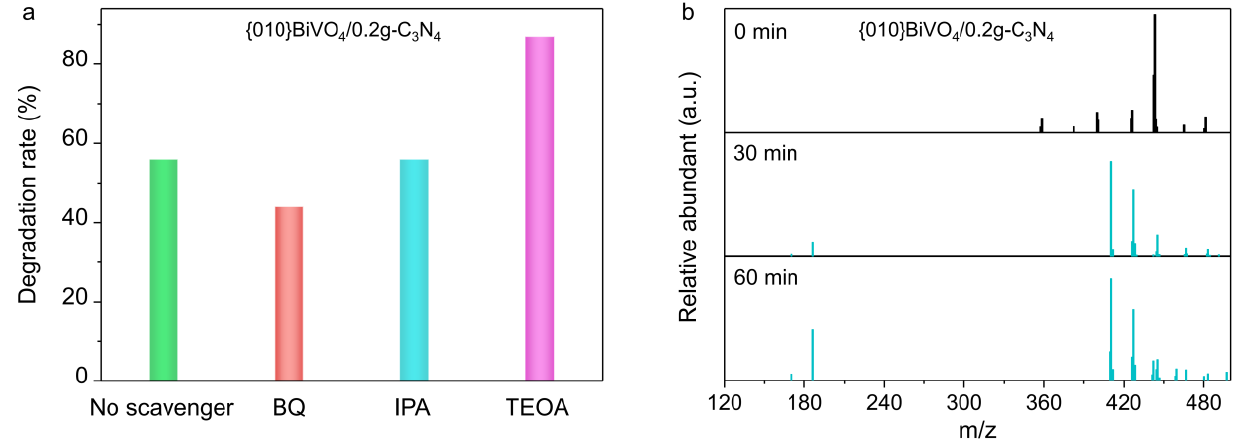
Figure 7. ( a ) Trapping experiments of active species during the photocatalytic degradation of TC over {010}BiVO 4 /0.2g-C 3 N 4 . ( b ) LC-MS spectra of intermediates over {010}BiVO 4 /0.2g-C 3 N 4 during TC degradation.